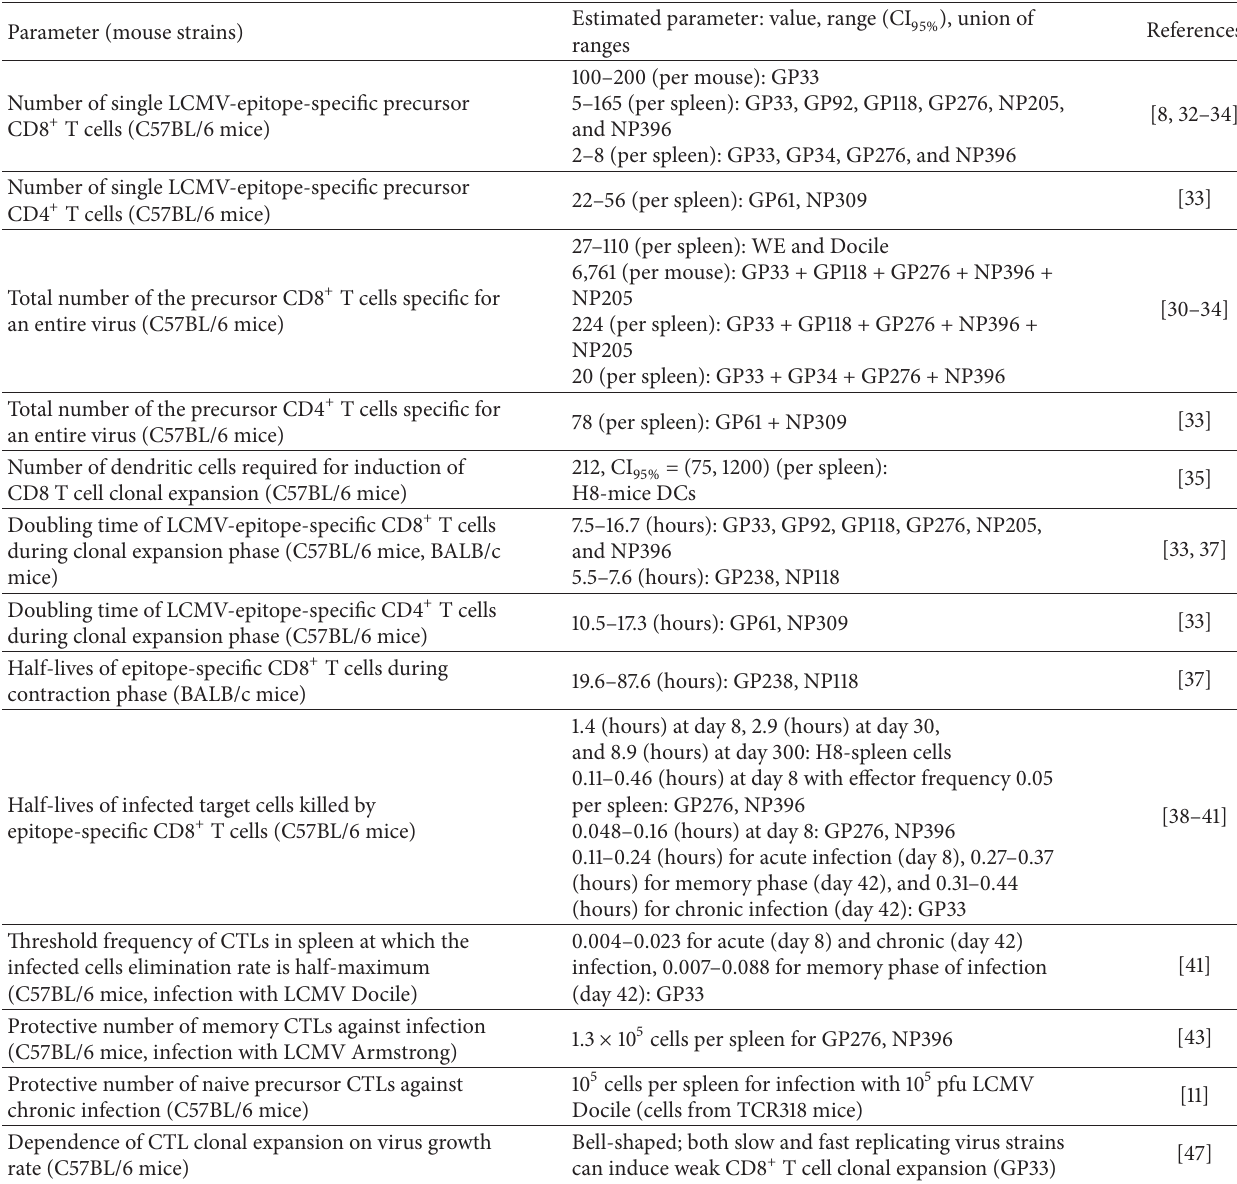
Table 1: Fundamental parameters of T cell response to LCMV infection and the relevant LCMV